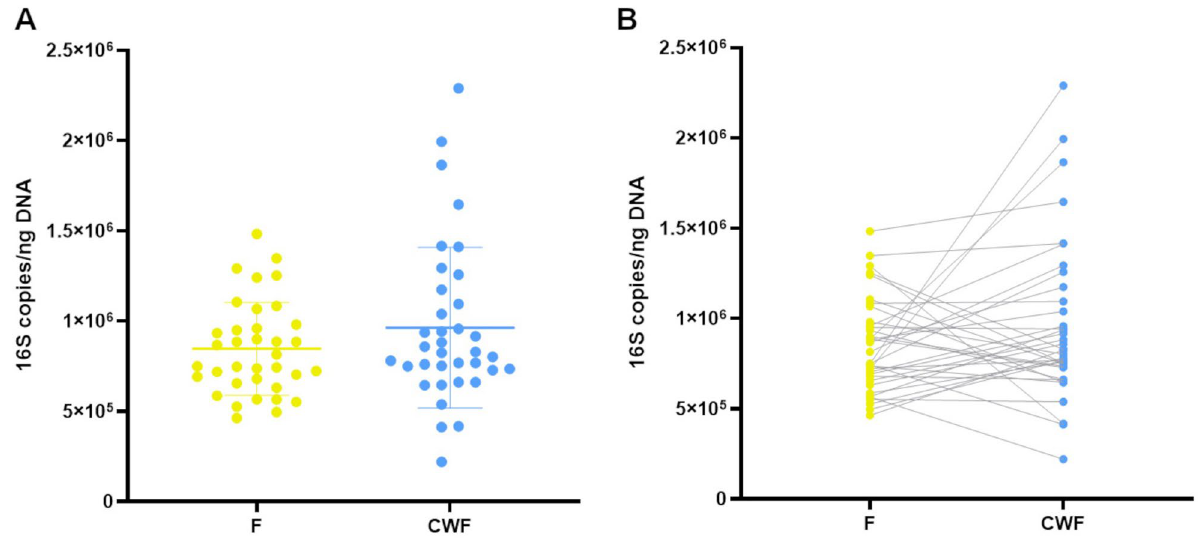
Figure 1. 16S absolute quantification of DNA extracted from F and CWF sample matrices. Data are reported as the mean of triplicate ddPCR experiments and expressed as 16S copies/ng of total DNA ( A dot-plot; B dumbbell